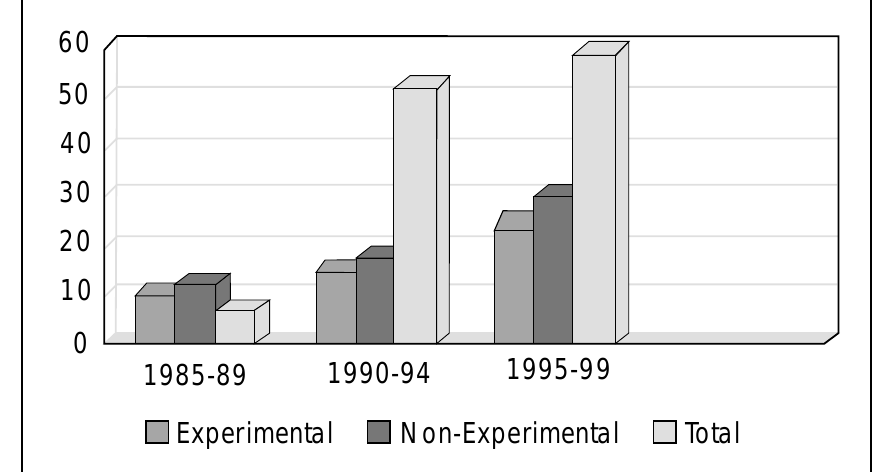
Figure 2: Comparison of experimental vs non-experimental